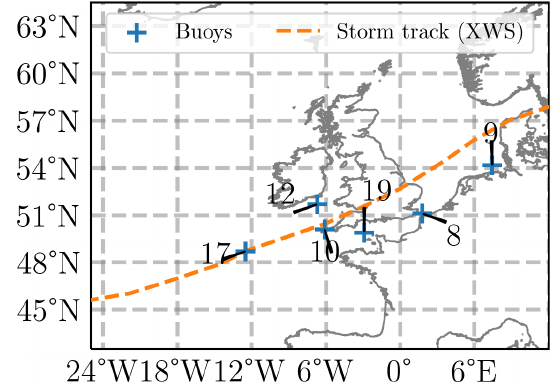
Figure 2. Geographic location of the six buoys together with the track of storm Christian obtained from the Extreme Wind Storms Catalogue (XWS, Roberts et al., 2014, http://www. europeanwindstorms.org, last accessed: 21 October 2021) for ref- erence. Table 1. Identifiers, geographic location of the six buoy locations as well as the sea level pressure threshold p t used for the storm duration analysis at that station. Stations are listed from west to